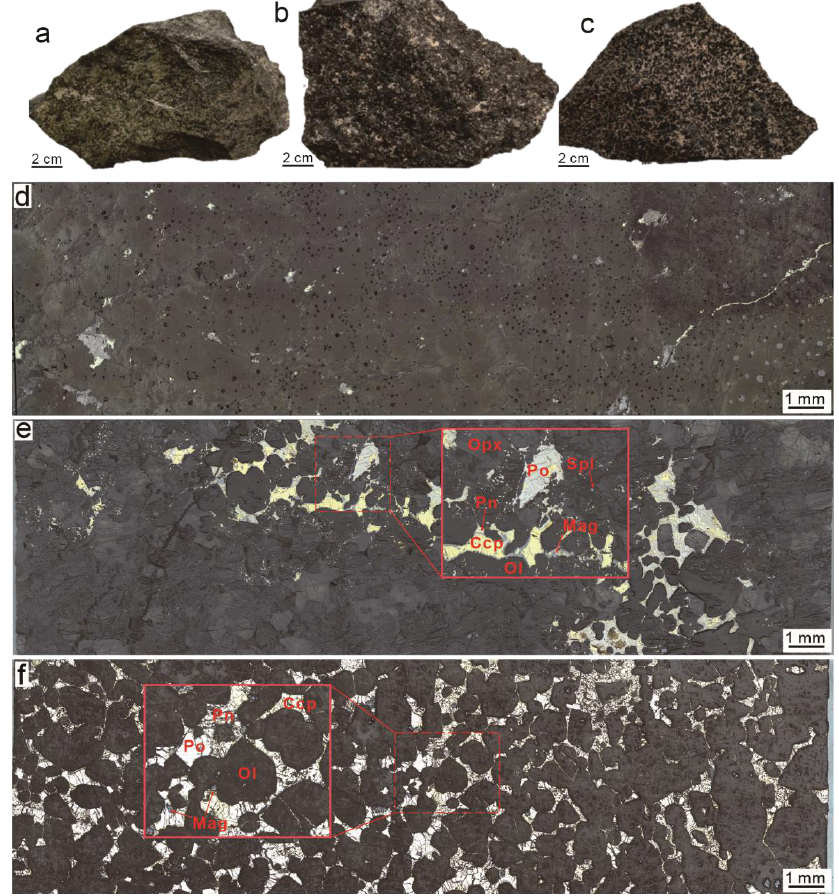
Figure 3. Photos of hand samples of the ( a ) mafic–ultramafic intrusions, ( b )disseminated and ( c ) net- textured ores from the Jinchuan deposit. Scanned slab of the typical ( d ) mafic–ultramafic intrusion, ( e ) disseminated and ( f ) net-textured ores from the Jinchuan deposit. Ccp: chalcopyrite, Ol: olivine, Opx: orthopyroxene, Pn: pentlandite, Po: pyrrhotite, Spl: spinel, Mag: magnetite.